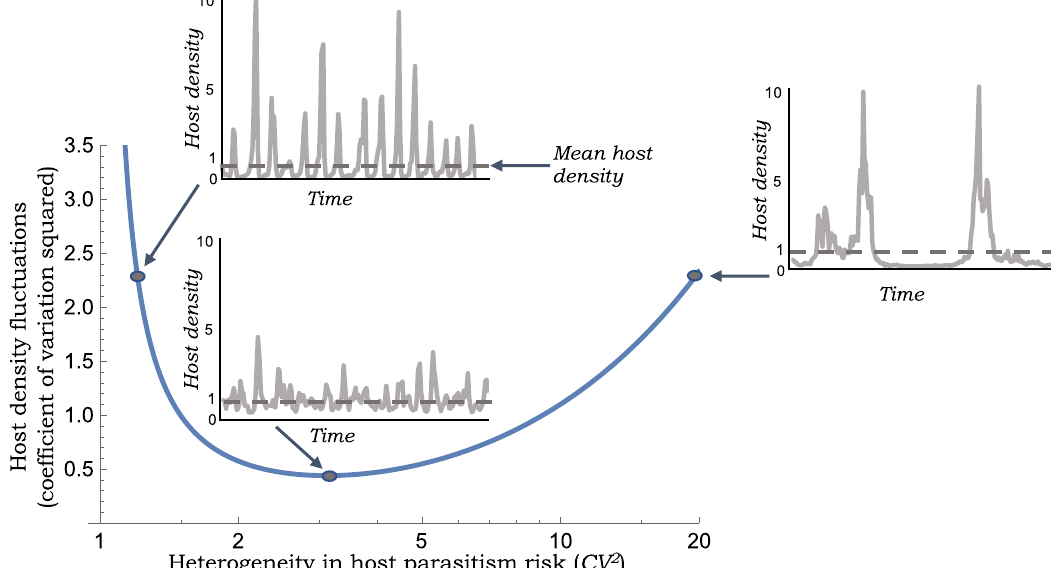
Figure 1. Extent of fluctuations in the host population density are minimized at an intermediate level of heterogeneity in parasitism risk. The steady-state coefficient of variation squared of the host population density as predicted by (14) and (16) is plotted as a function of the heterogeneity in parasitism risk CV . Three examples of host density fluctuations are generated by performing stochastic simulations of model (3)-(4) for different values of CV assuming ¯ c = 1 , R = 2 and σ 2 R = 1 . All time series are normalized to have a mean value of